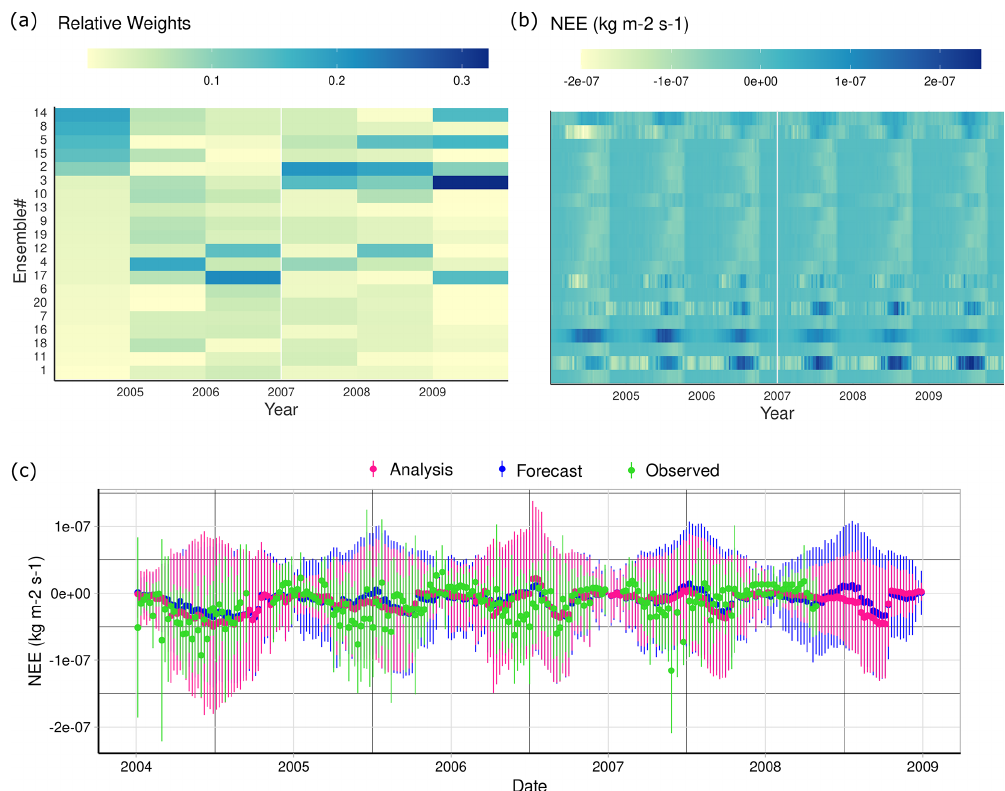
Figure 8. (a) Weekly NEE predictions for all ensemble members at the Black Hills site. (b) Relative weight estimated for each ensemble member using Eq. (10) sorted by cumulative weight from highest (top) to lowest (bottom). (c) Weekly average adjusted NEE (analysis) compared to the observed